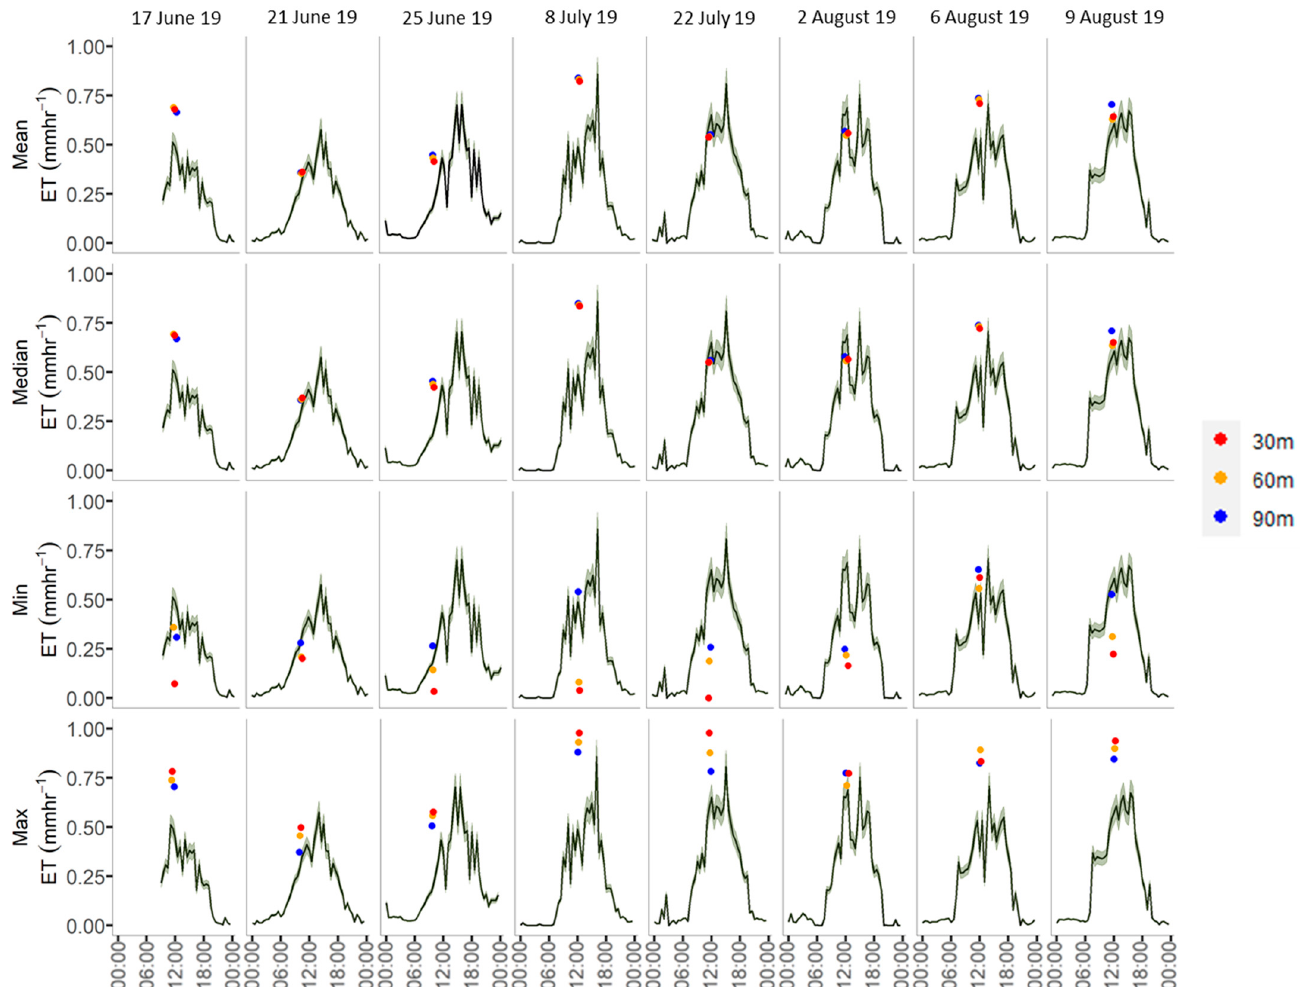
Figure 11. Daily timeseries of EC ET (mm h − 1 ) and instantaneous HRMET ET (mm h − 1 ) across the 8 mission sets. A 10% buffer added to the EC time series.